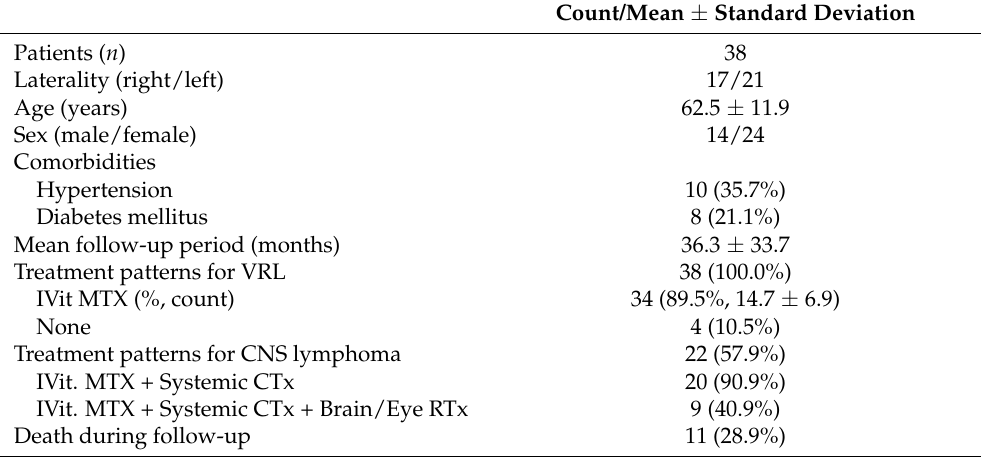
Table 1. Demographic characteristics of the study population.